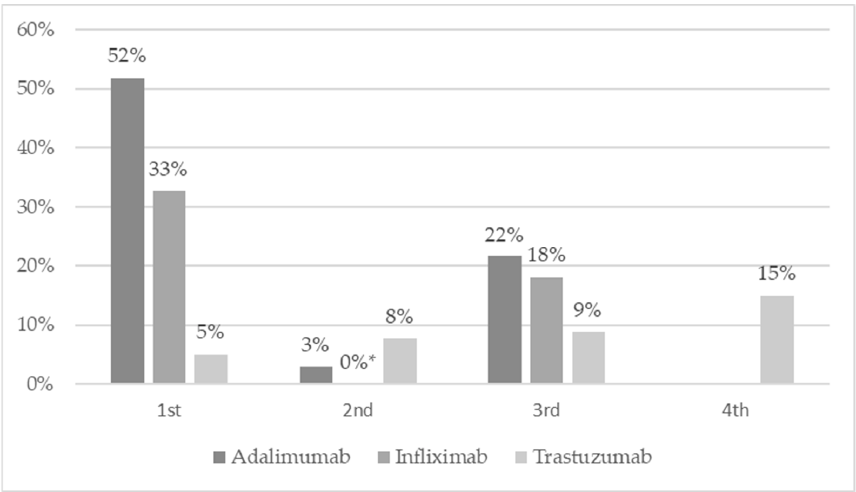
Figure 2. Comparison of price drops correlated with the introduction of consecutive biosimilars in percentage terms (current price vs price from the previous reimbursement list). Source: own elaboration based on Ministry of Health data [9].